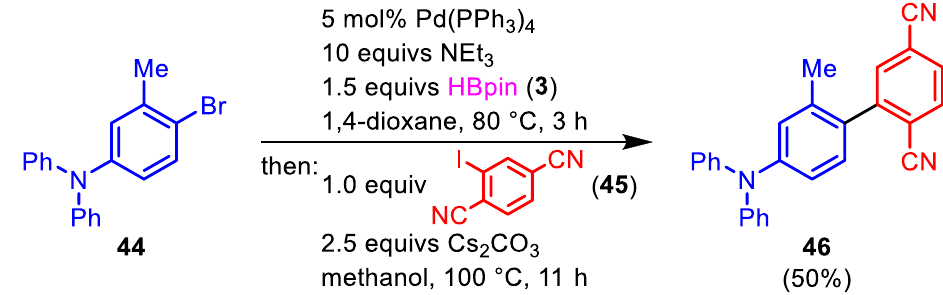
Figure 27. One-pot MBSC synthesis of TADF dye 46 by Sommer et al. [56].